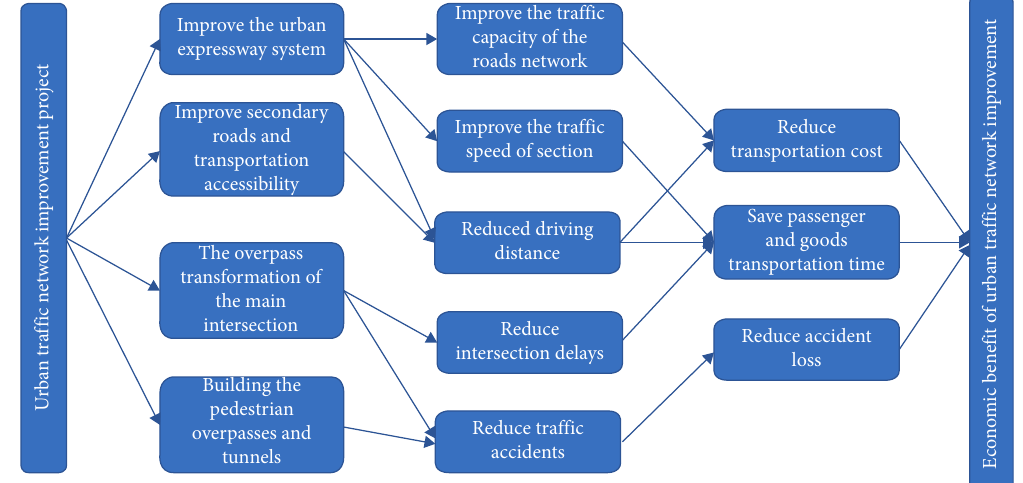
Figure 3: Causality diagram of road network improving economic